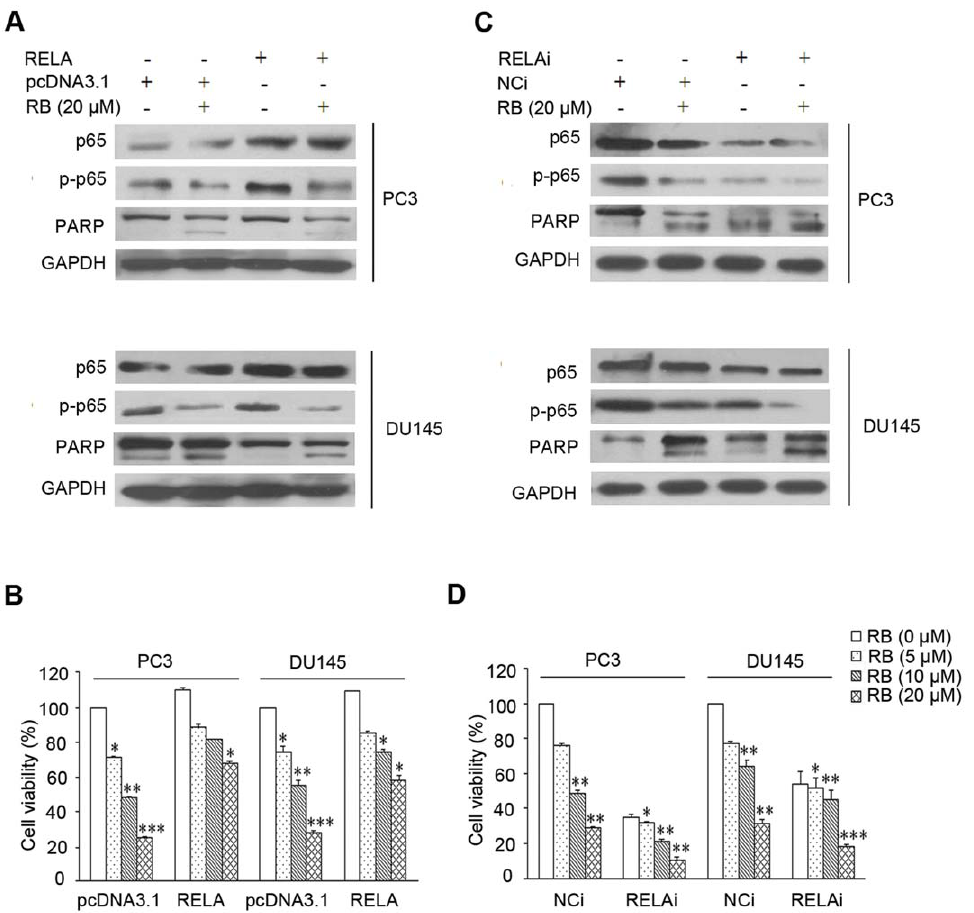
Figure 5. RELA is involved in RB-induced apoptotic cell death. (A) and (B) RELA overexpression by transfection of a RELA expression vector partially abolished cytotoxicity in PC3 and DU145 cells. Cells were transfected with siRNA of RELA (RELAi) or with a negative control siRNA (NCi), using a 50 nmol/L final siRNA concentration. After 48 h transfection for RELA overexpression, the effect of RB on p65, p–p65, and PARP expression in RELA transfected cells was determined by western blot; cell viability was also determined after additional exposure for 24 h to RB. (C) and (D) Silencing of RELA expression by siRNA increased cytotoxicity induced by RB. Similar procedure was performed for the studies on RELA. The details are described in Material and Methods . In (A) and (C), the protein levels of p65 and p–p65 were normalized with GAPDH. Results shown are representatives of three independent experiments. In (B) and (D), p , 0.05 (*), p , 0.01 (**), p , 0.001(***) versus RB-untreated control group, respectively.